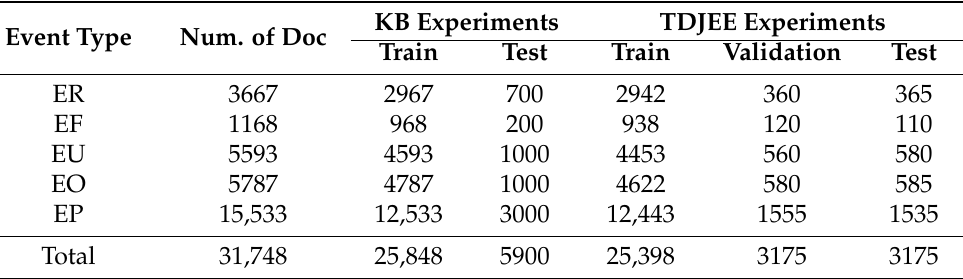
Table 2. Statistics of dataset for evaluating construction of knowledge base and TDJEE. Num. of Doc represents the number of documents. Train, Validation, and Test means the numbers of documents for training, validating, and testing,